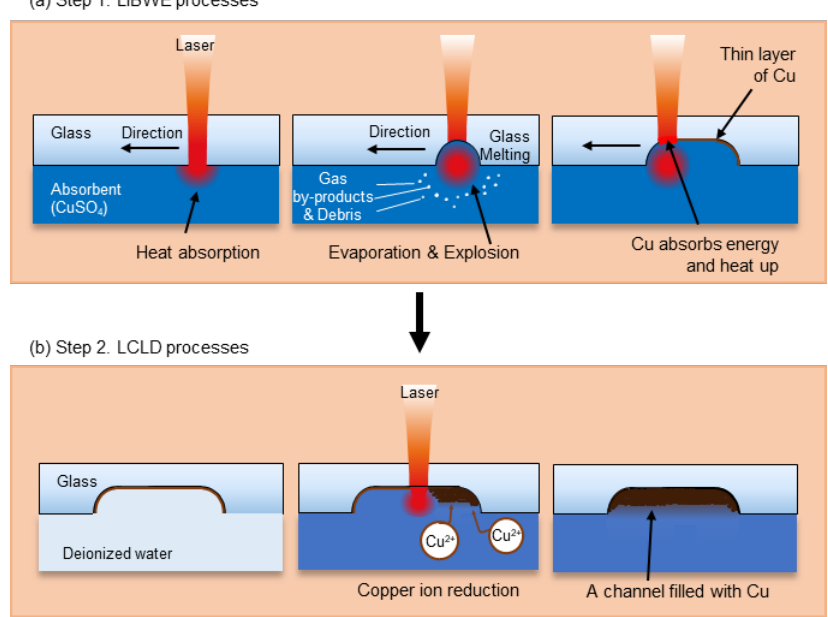
Figure 4. Sequence of the overall experiment. ( a ) LIBWE is applied as the first step. ( b ) LCLD is applied as the second step.